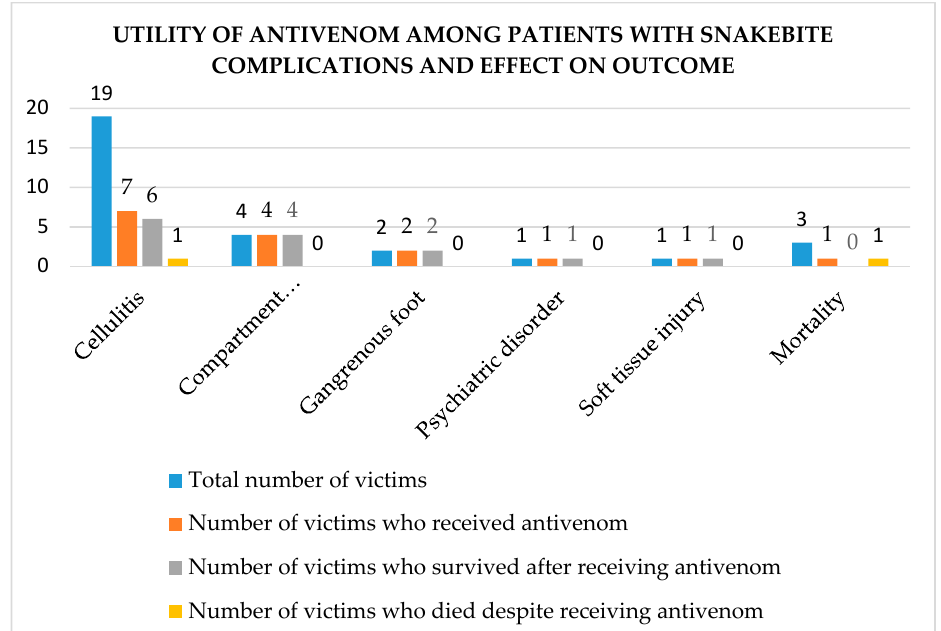
Figure 3. Utility of antivenom and outcome among patients with snake bite related complications.